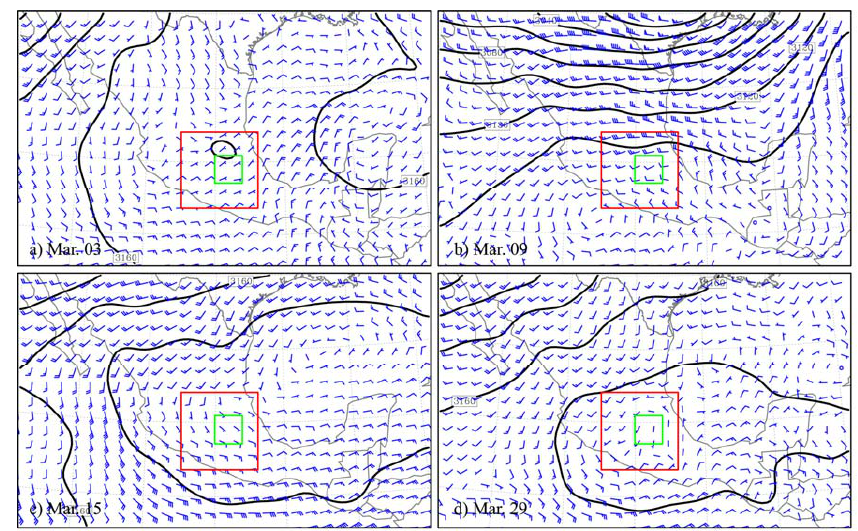
Fig. 3. The 700hPa geopotential heights and winds at 12:00CDT from GFS-FNL reanalysis data for (a) 3 March, (b) 9 March, (c) 15 March, and (d) 29 March, 2006. Red box indicates domain3 used in WRF. Green box indicates the CAMx domain.